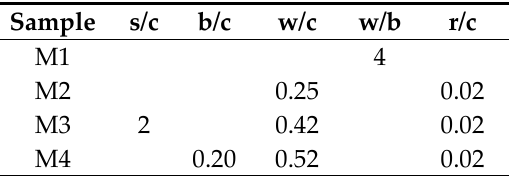
Table 2. Dosage of the